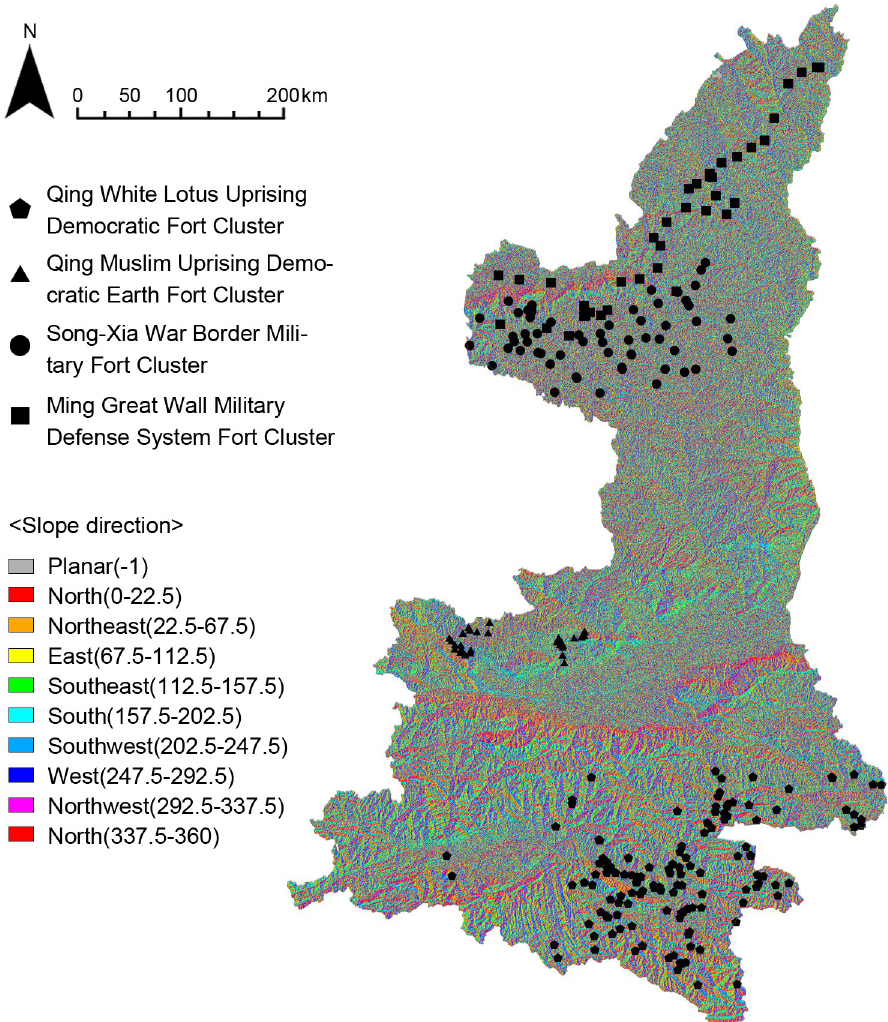
Fig 16. Analysis of slope